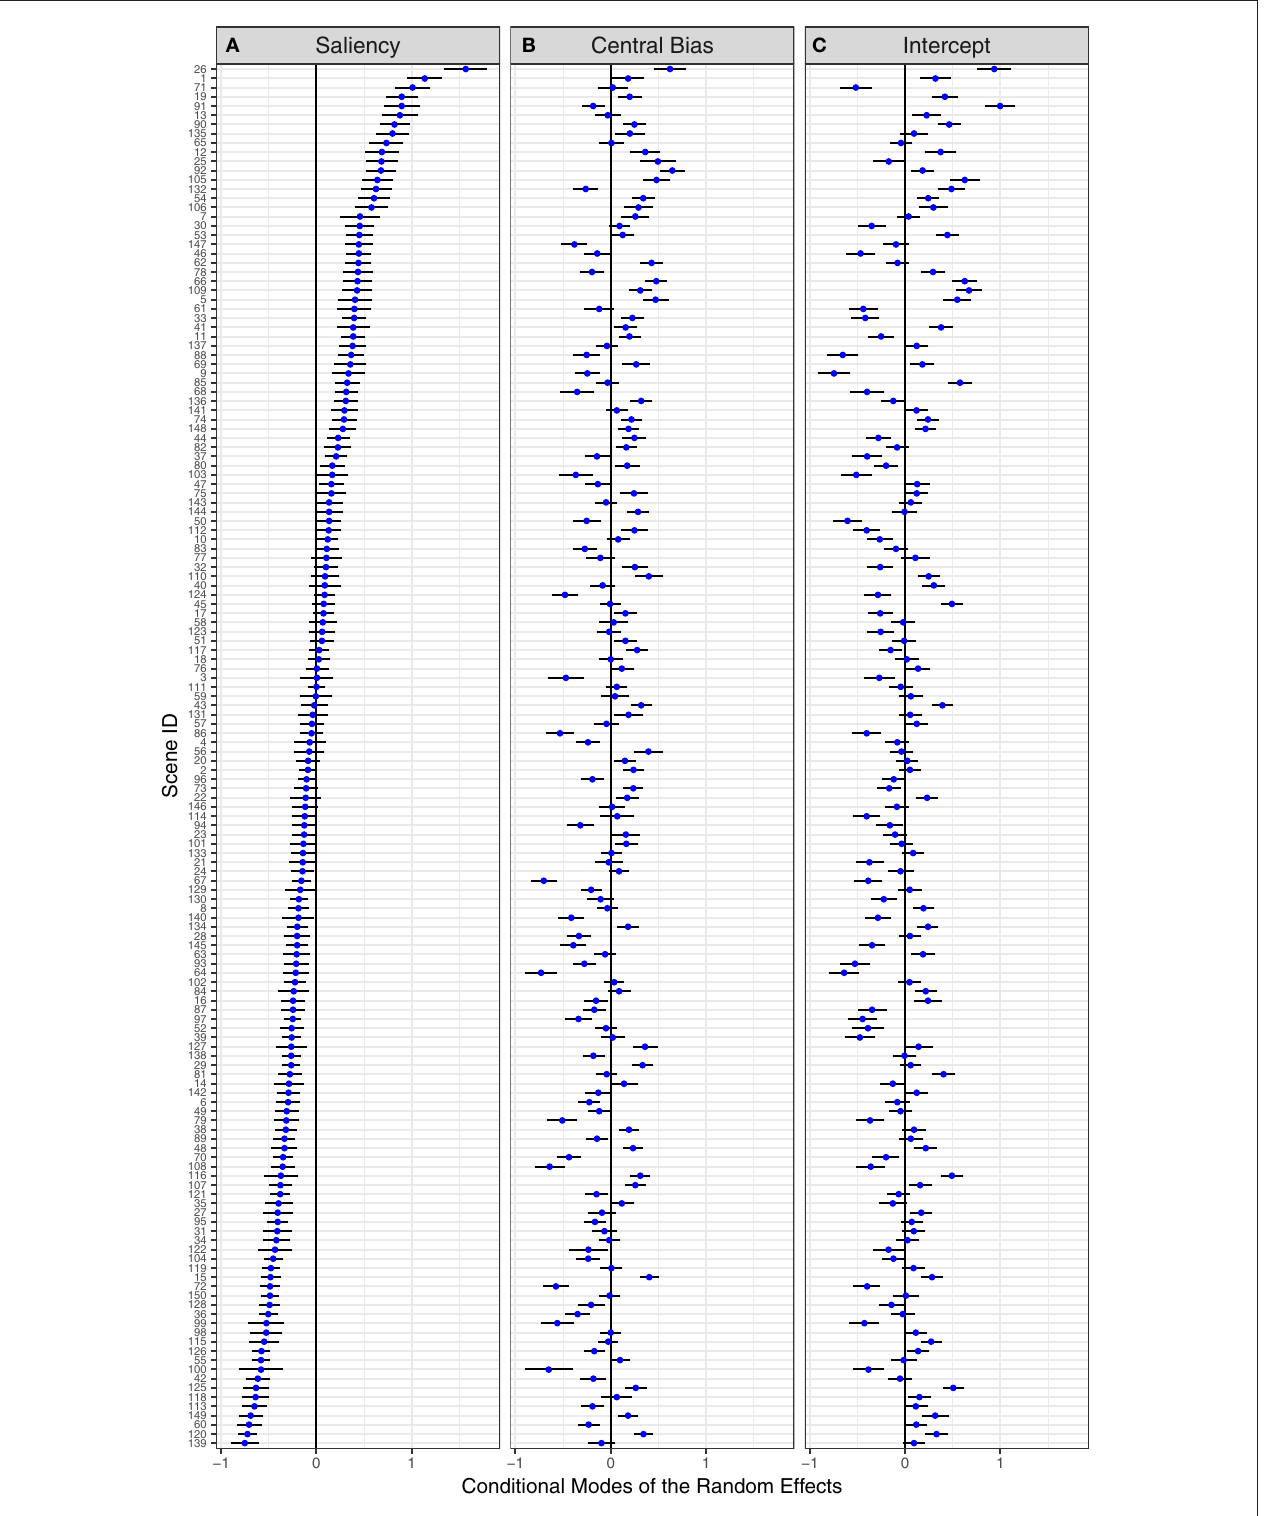
FIGURE 7 | By-item random effects for the Central-Bias—Saliency GLMM testing Adaptive Whitening Saliency. “Caterpillar plots” for conditional modes and 95% prediction intervals of 150 scene items for (A) saliency effect, (B) central-bias effect, and (C) mean fixation probability. Scene items are ordered by the saliency effect. The numbers on the y-axis are the scene IDs.